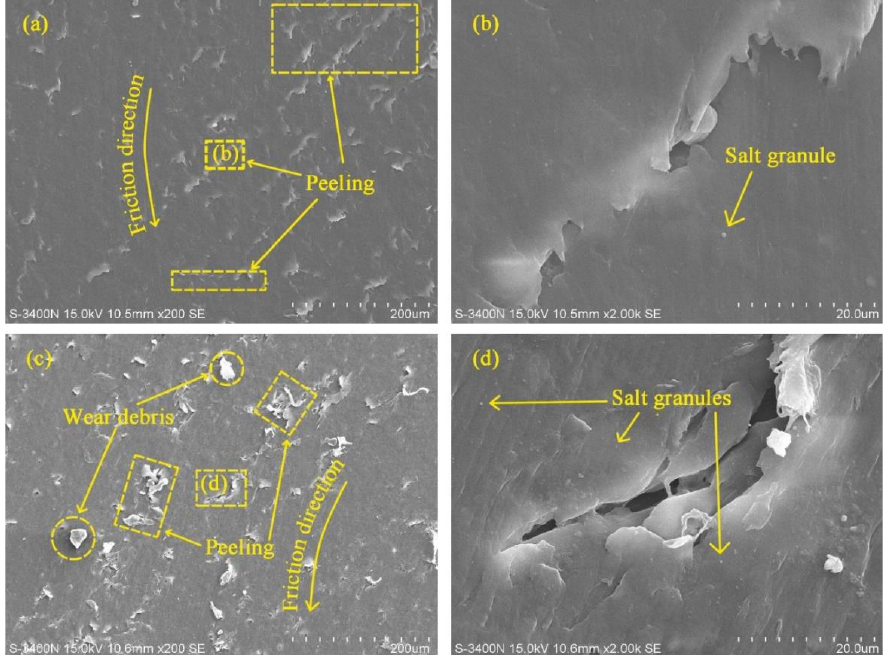
Figure 6. SEM micrographs of worn surfaces of UHMWPE under brine-unsaturated lubrication conditions ( a ) 50 N load and ( c ) 110 N load; ( b , d ) are images taken at the marked positions in the micrographs.